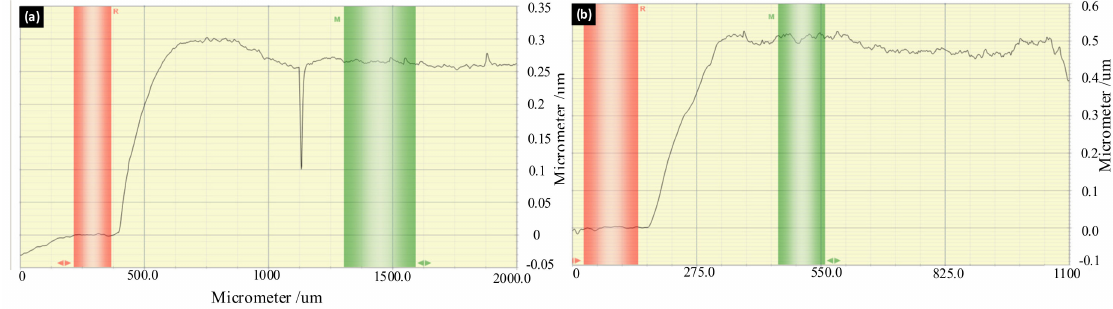
Figure 8. Simplified model for printing on the conformal surface using the arrayed nozzle: ( a ) formation of gaps between neighboring droplets during the printing process from the arrayed nozzle when all droplets share the same size; ( b ) droplet size calculated based on the geometric model; and ( c ) the printing model proposed in this study. ( d ) Actual e ff ect of direct printing on the surface; and ( e ) actual e ff ects of printing with the method proposed in this article.